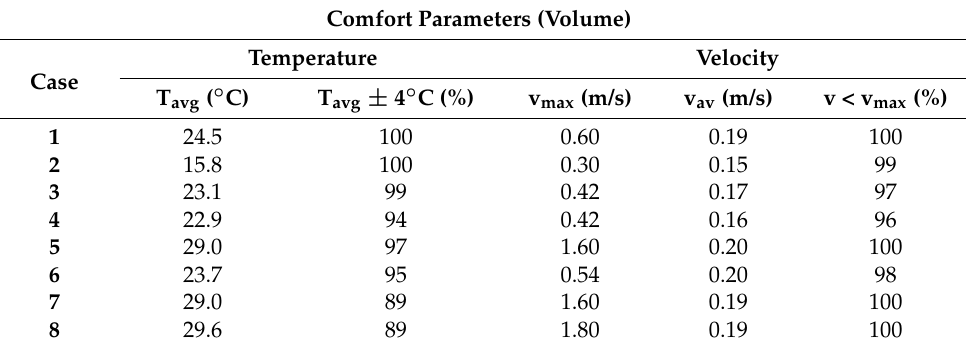
Table 7. Velocity requirement depending on the average temperature (category